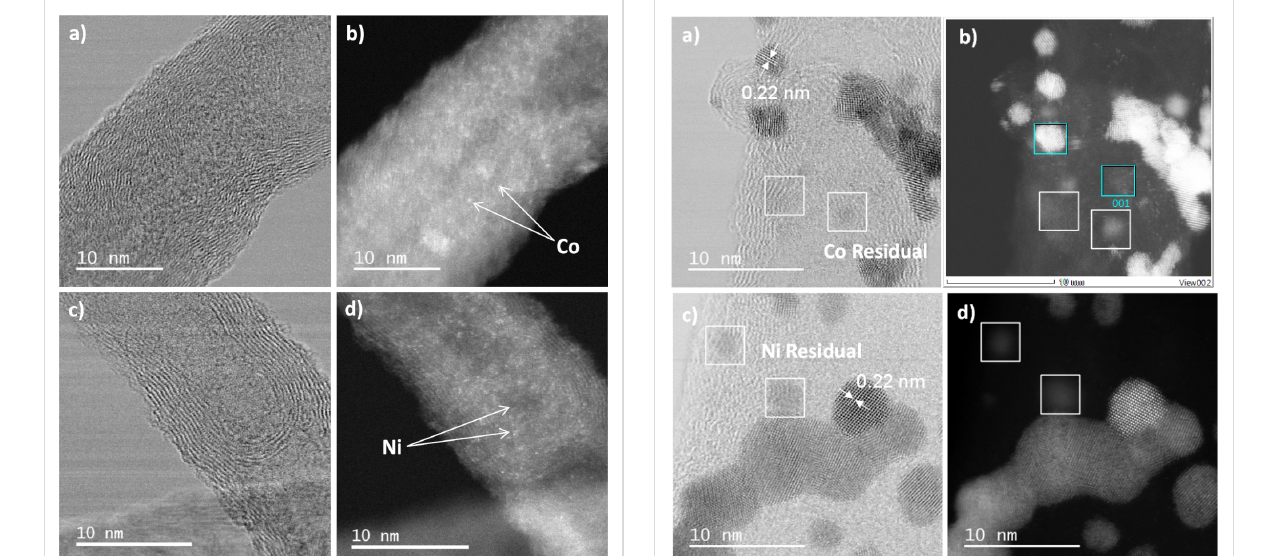
HRTEM images of the bimetallic catalysts Pt 3 Co/N-CNT and Pt 3 Ni/N-CNT HT do not evidence the formation of core–shell NPs (Figure 7). The interplanar distance of 0.22 nm was found